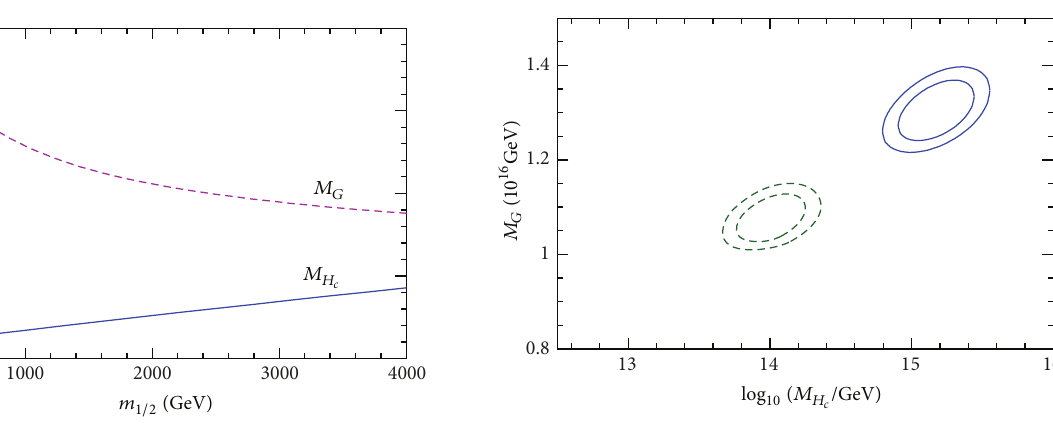
Figure 8: Dependence of 𝑀 𝐻 (solid) and 𝑀 𝐺 (dashed) on 𝑚 1/2 𝑐 from [51].